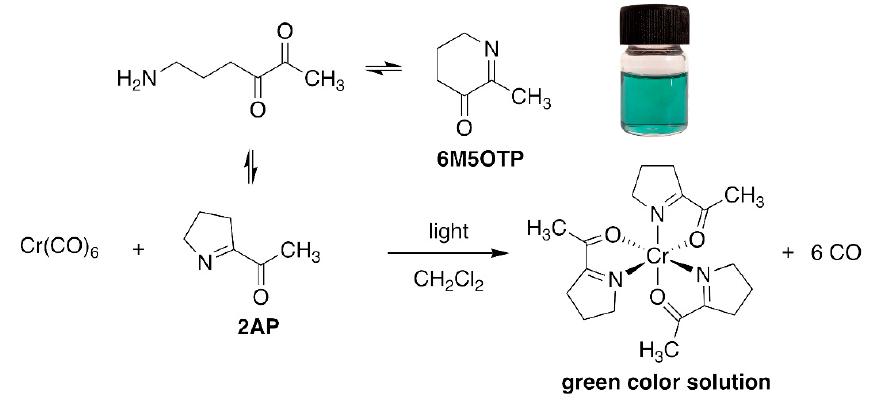
Figure 1. Possible mechanism for the light-assisted complexation of Cr(CO) 6 and